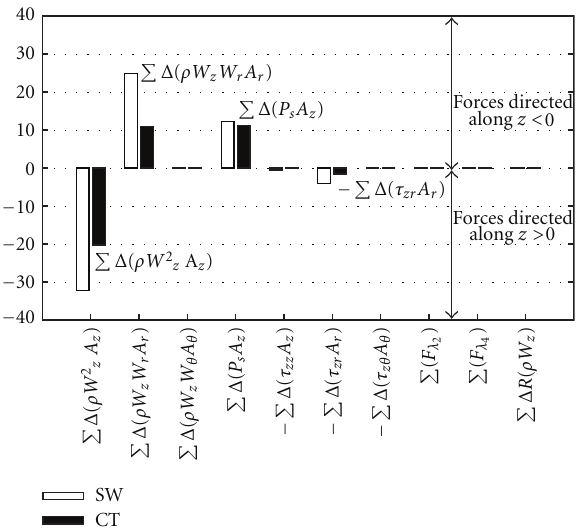
Figure 11: NASA Rotor 37 with and without CT: balance of the axial momentum equation.